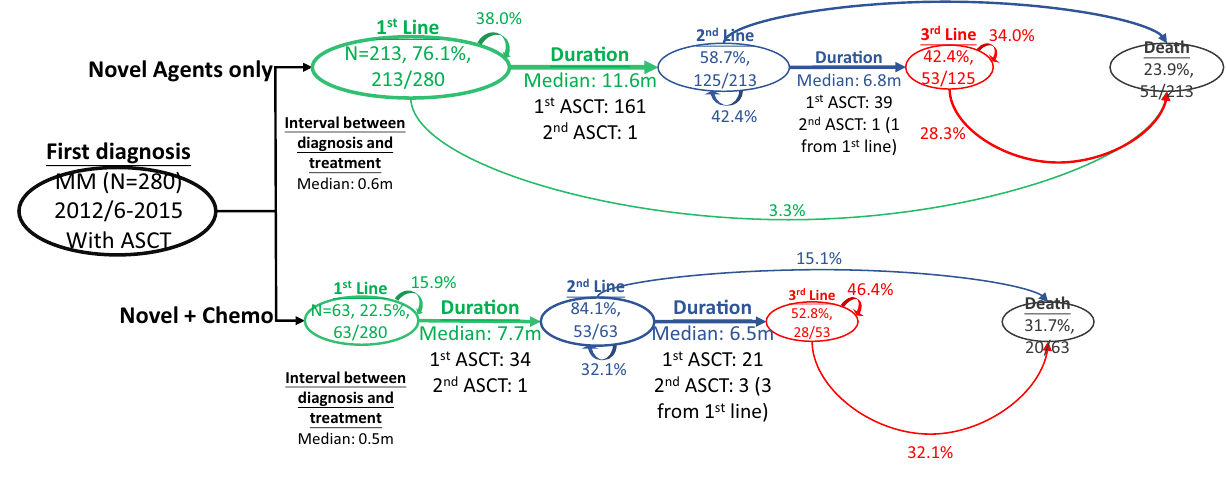
Figure 2. Disease progression model in patients diagnosed with MM in the post-bortezomib periods who received ASCT. The DPMs illustrate the percentage of patients who moved from first-line, to second-line through to the end of third-line treatment according to the type of first-line therapy received and includes those who died or received ASCT during their disease journey. Arrows that return to the line of therapy indicate patients who stayed on the line of therapy for the study duration. Arrows to ‘Death’ indicate the percentage of patients who died at each treatment line. Duration refers to the gap between commencement of one line of therapy and the next. The figures (lengths, widths, areas etc.) are directly proportional to the numbers displayed. ASCT autologous stem cell transplant, MM multiple myeloma, Tx